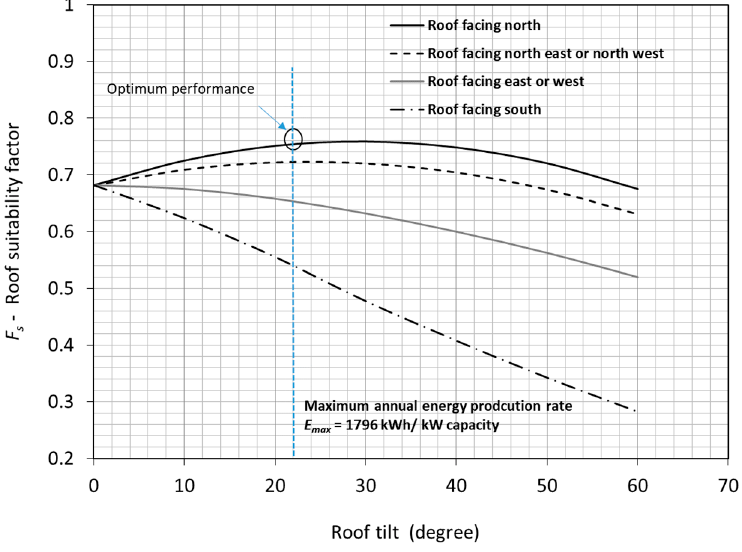
Figure 1. Roof suitability factor for rooftop PV system application in Sydney.